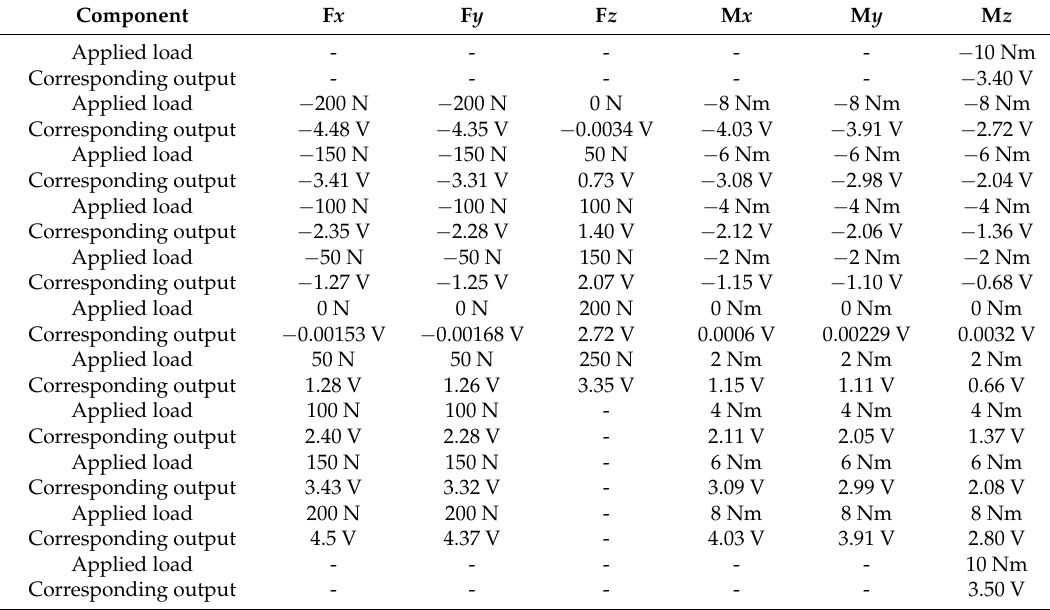
Table 5. The outputs of the sensor.